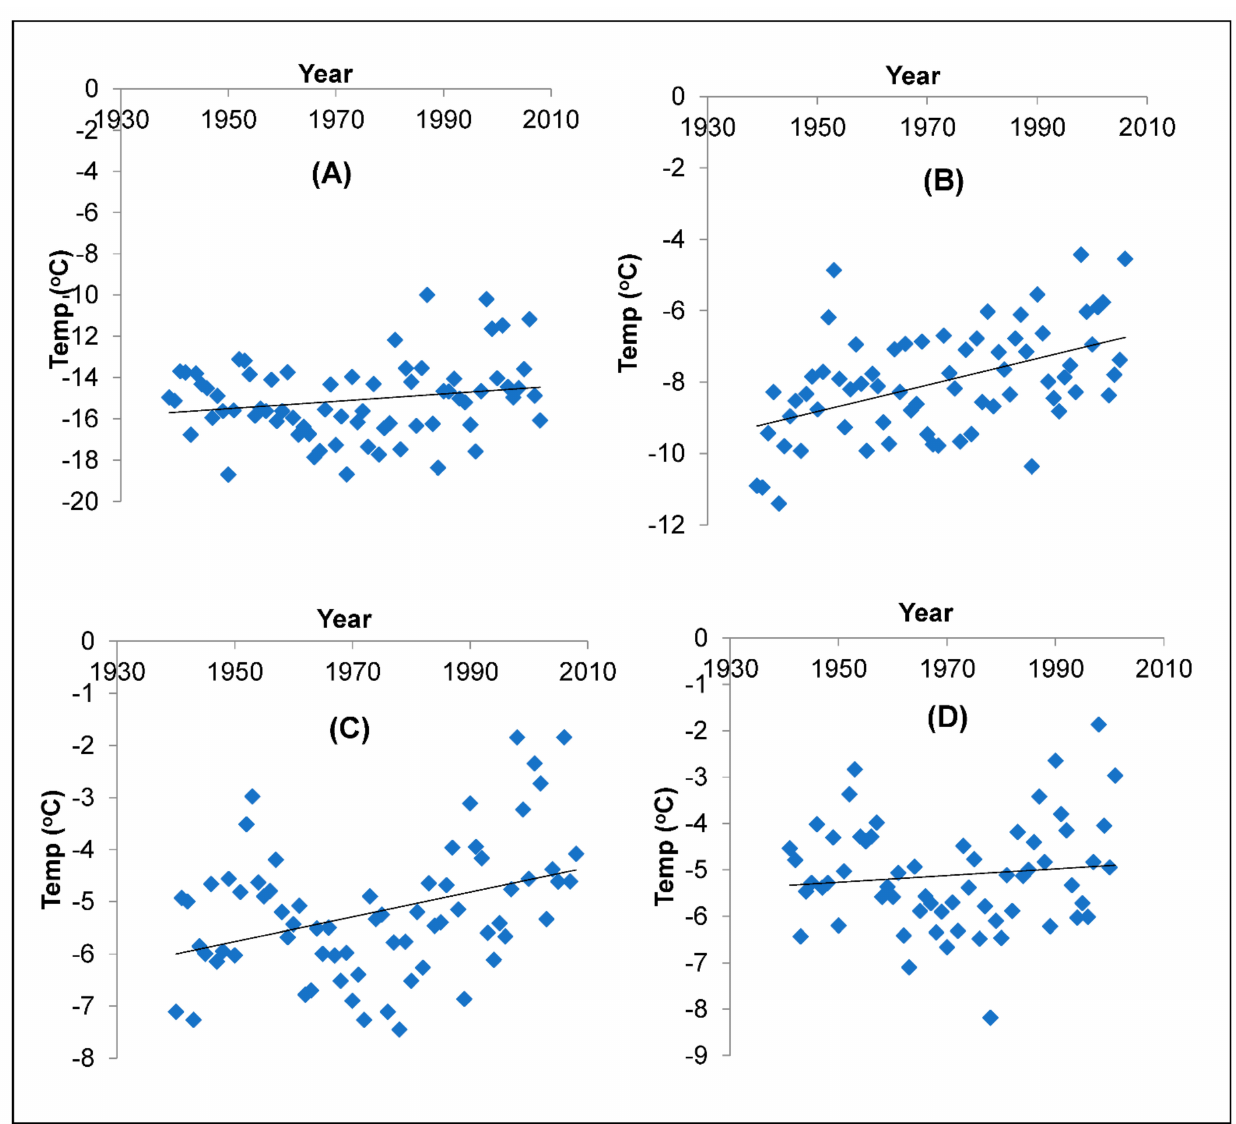
Figure 3. Time series plots of winter minimum temperature at Sioux Lookout ( A ), Ottawa ( B ), Toronto ( C ), and London ( D ),